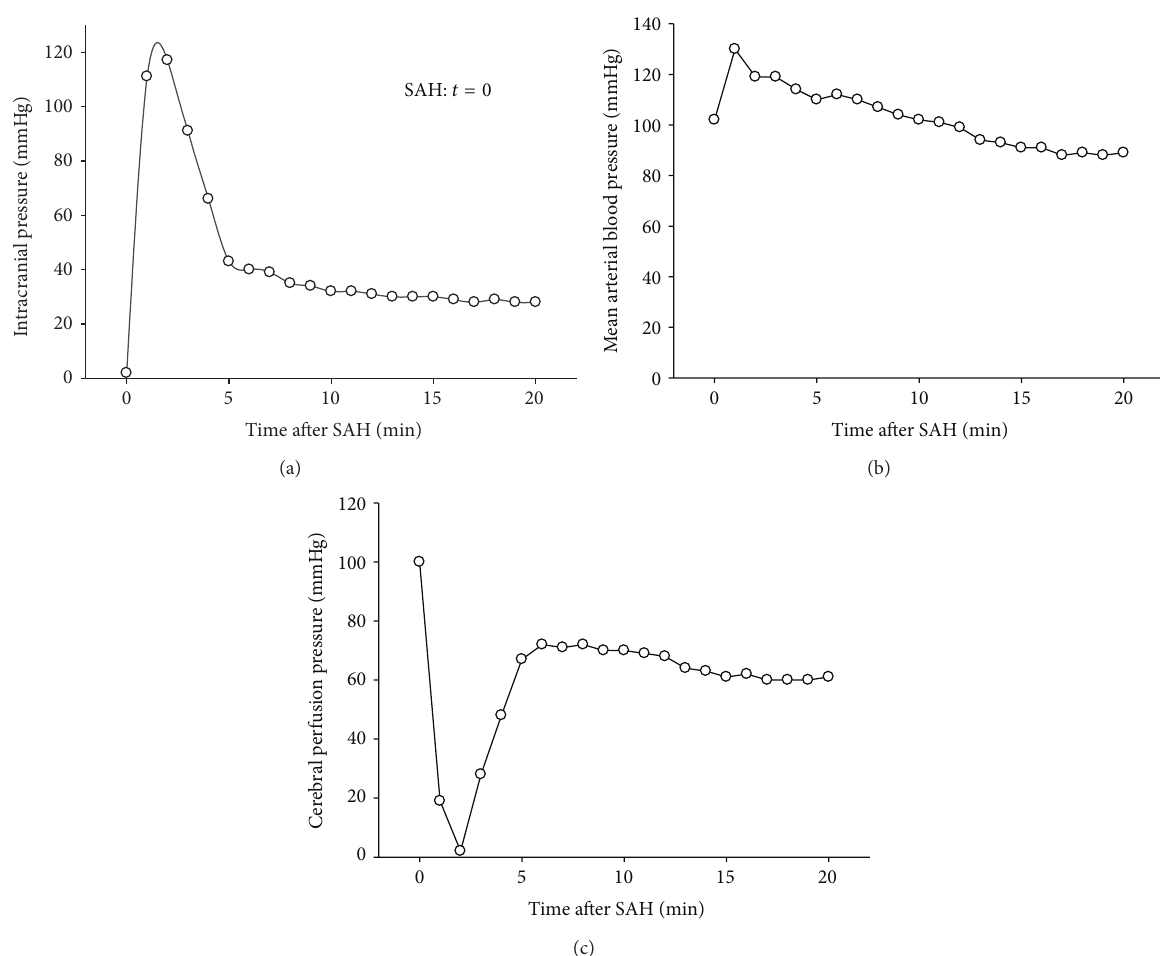
Figure 2: Intracranial pressure (ICP; (a)), mean arterial blood pressure (MAP; (b)) and cerebral perfusion pressure (CPP; (c)) after SAH in a mouse ( 𝑡 = 0 ; endovascular perforation